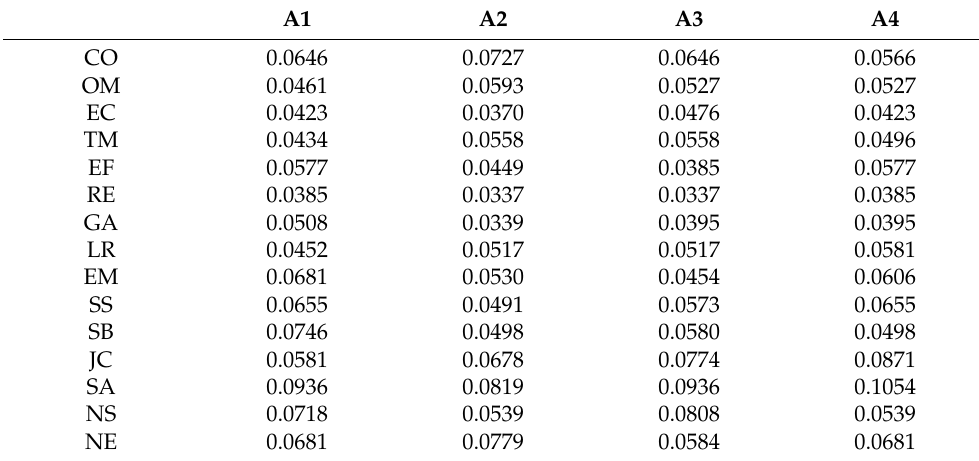
Table 6. Weighted Normalized